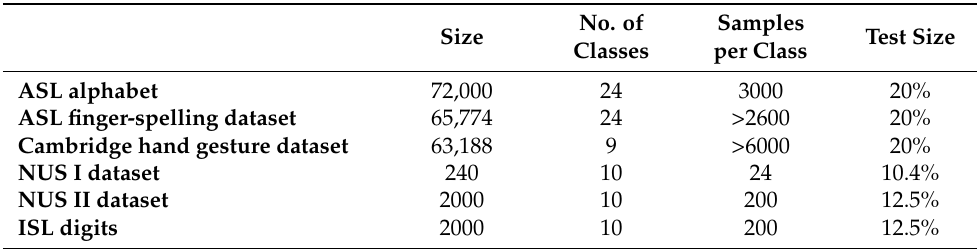
Figure 1. Datasets–ASL alphabet, ASL finger-spelling dataset, Cambridge dataset, NUS I and II, ISL digits.